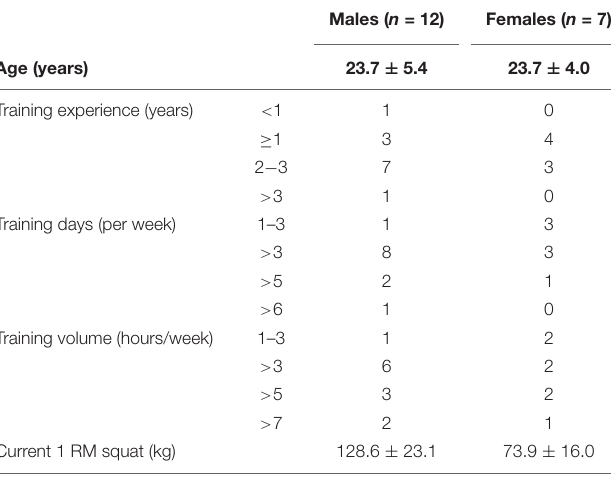
TABLE 1 | Demographic information of the